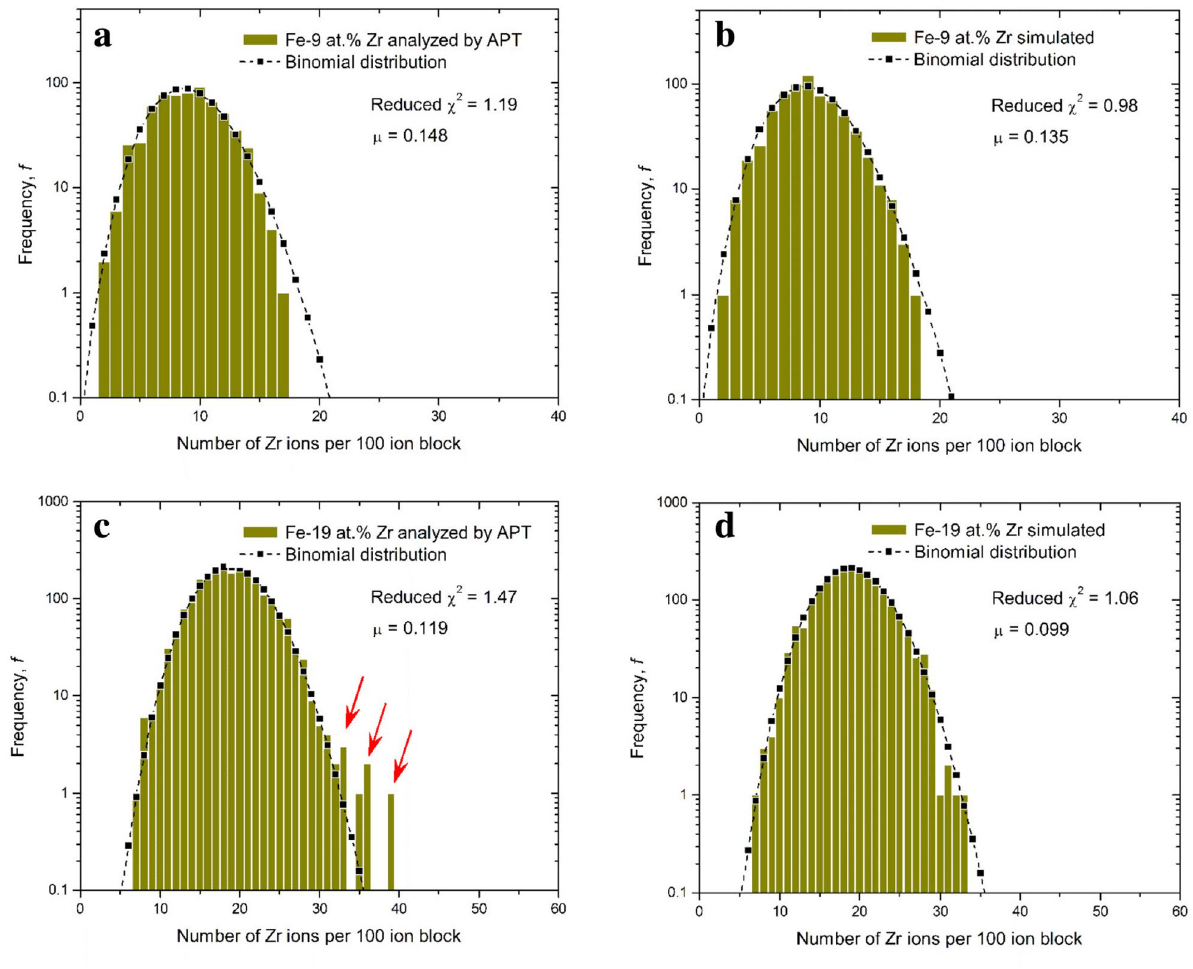
Fig. 7. Measured Zr concentration histogram in a cubic volume of Fe 0.91 Zr 0.09 ( a ) and Fe 0.81 Zr 0.19 ( c ). For comparison, the simulated Zr concentration histograms for a random solution of similar size and the respective compositions are included in ( b ) and ( d ). The block size is 100